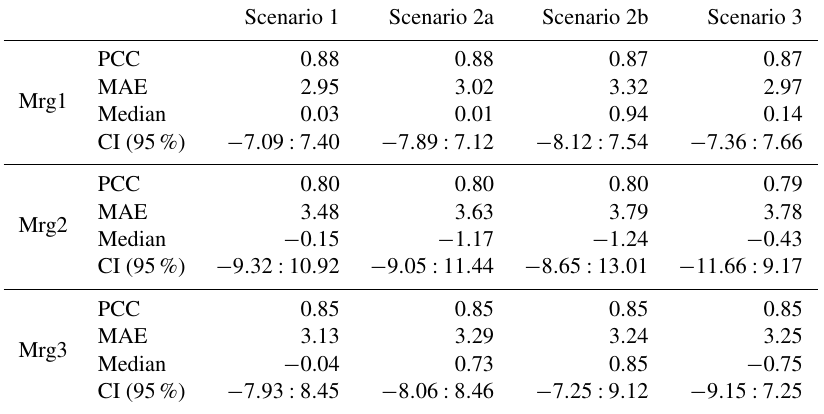
Table 5. Summary of the performances of the LCS bias model in the three scenarios considered. In scenario 1, we corrected one LCS bias using its environmental model coefficients within the full data set. In scenario 2a, we corrected a LCS bias averaging the environmental model coefficients of all the LCSs within the full data set. In scenario 2b, we corrected a LCS bias averaging the environmental model coefficients of the others two LCSs within the full data set. In scenario 3, we corrected a LCS bias using the LCS calculated environmental model coefficients considering only the annual extremes meteorological conditions at Col Margherita. For each case, the final Pearson correlation coefficient (PCC) and mean absolute error (MAE) between the low-cost sensor and the reference instrument, the bias distribution median and the bias distribution confidence interval (CI) at 95% are